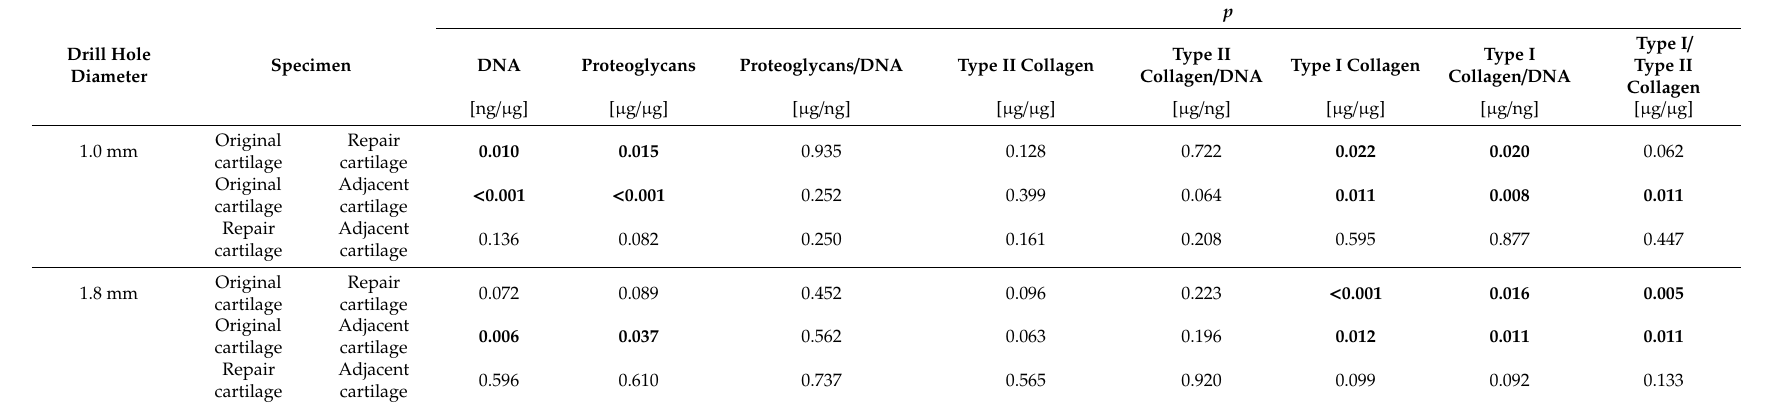
Table 2. Statistical comparison between the biochemical parameters obtained within original cartilage, repair cartilage, and adjacent cartilage.